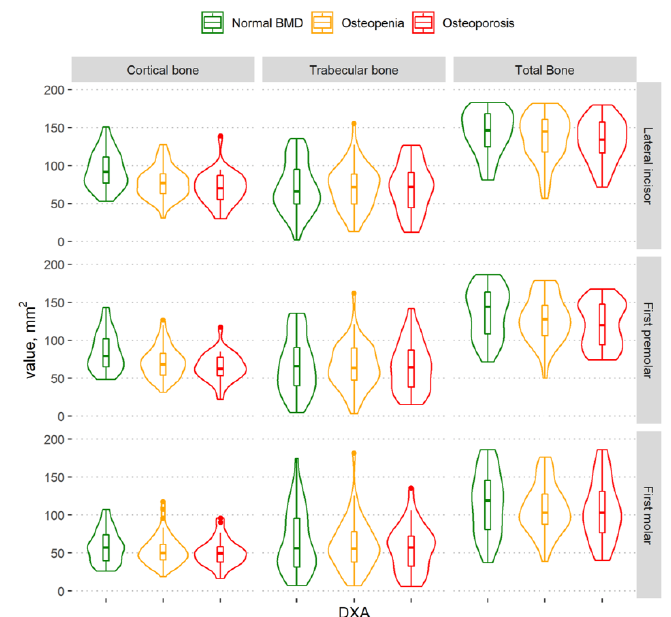
Figure 4. Violin plots of the cortical, trabecular, and total bone volume measurements in different BMD groups in the regions of the lateral incisor, first premolar, and first molar in the complete mandibular area.